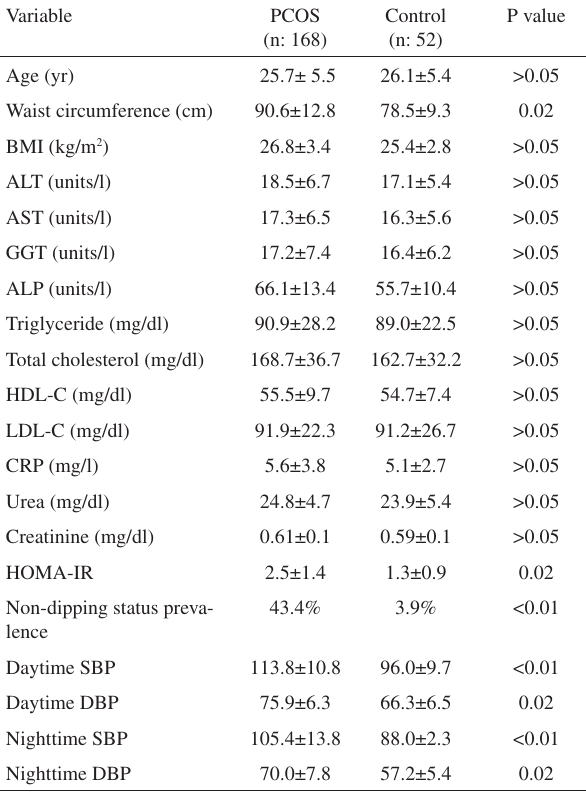
Table 1 - Descriptive data of the study group and healthy control